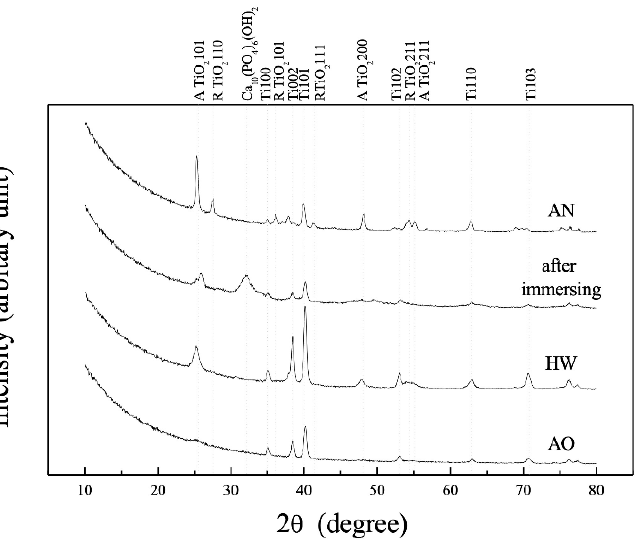
Figure 7. XRD profiles of the anodized oxide prepared in 1 M acetic acid and subsequent treat- ment . XRD profiles of the as-anodized oxide prepared in 1 M acetic acid electrolyte, the subsequent HW-treated oxide, and after immersion in Hank’s solution. The XRD profile of the annealed anodic oxide was used as a reference. XRD: X-ray diffraction; AN: annealed anodized oxide; AO: anodized oxide; HW: hot water-treated anodic